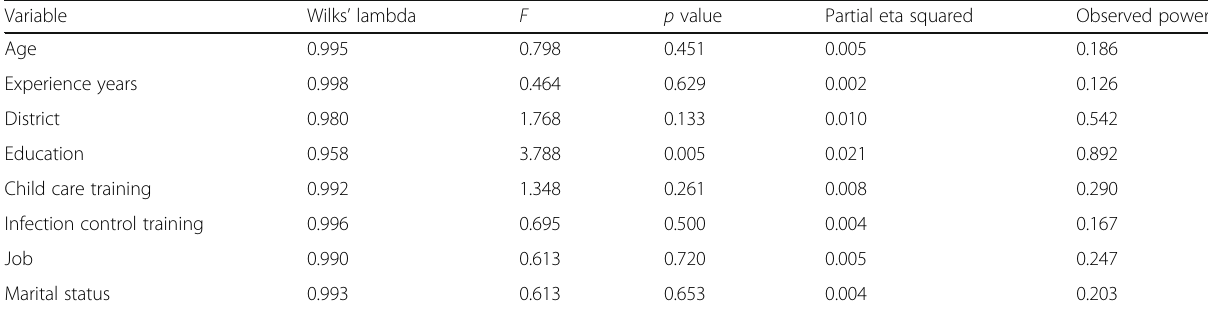
Table 1 MANOVA general F -test, factors affecting infectious diseases and infection control knowledge of caregivers (Alexandria, 2015) Variable